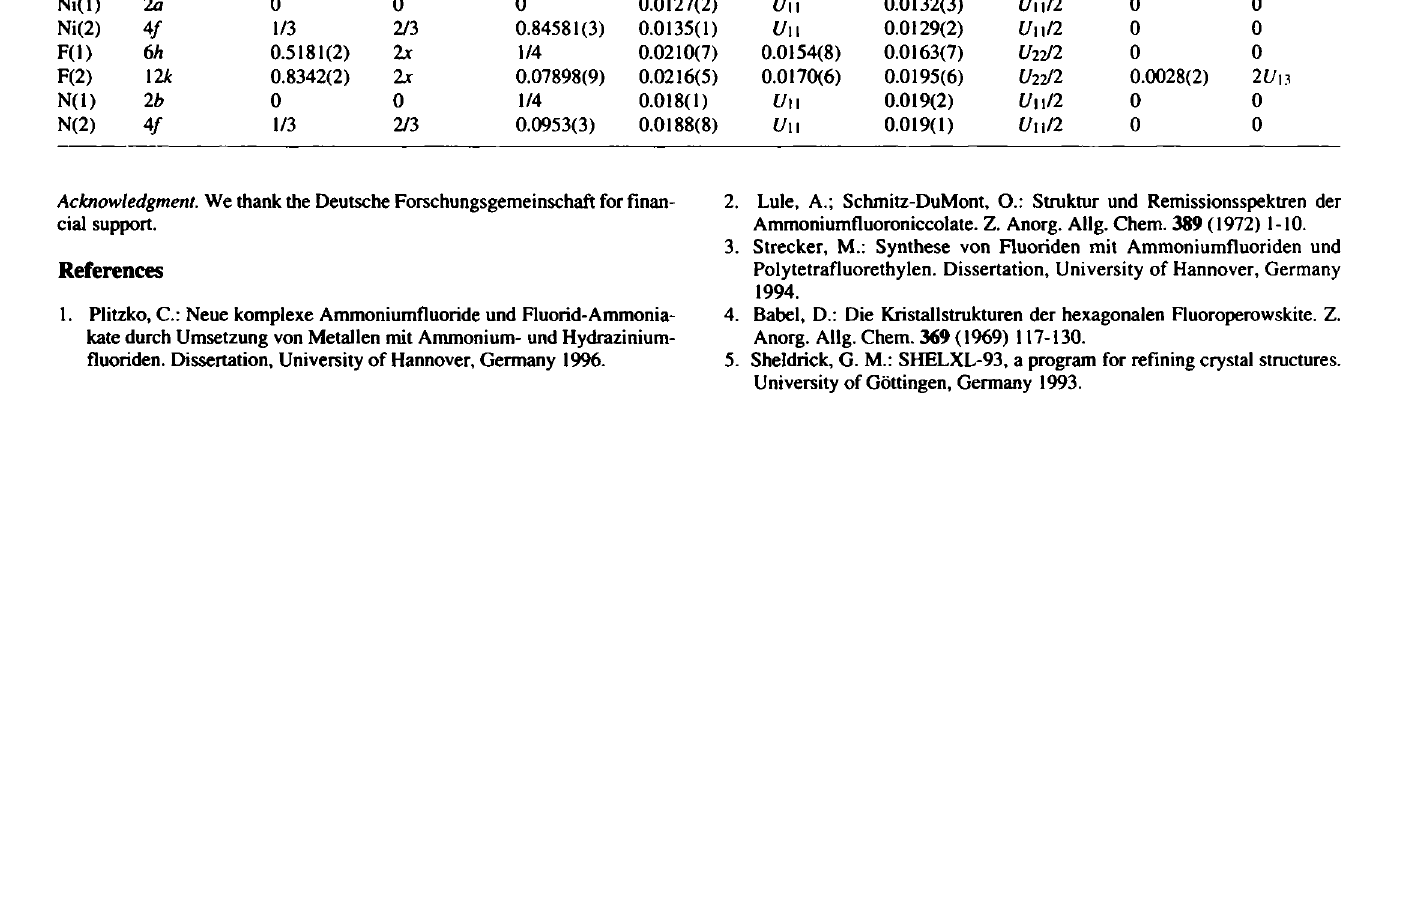
Table 4. Final atomic coordinates and displacement parameters (in Â 2